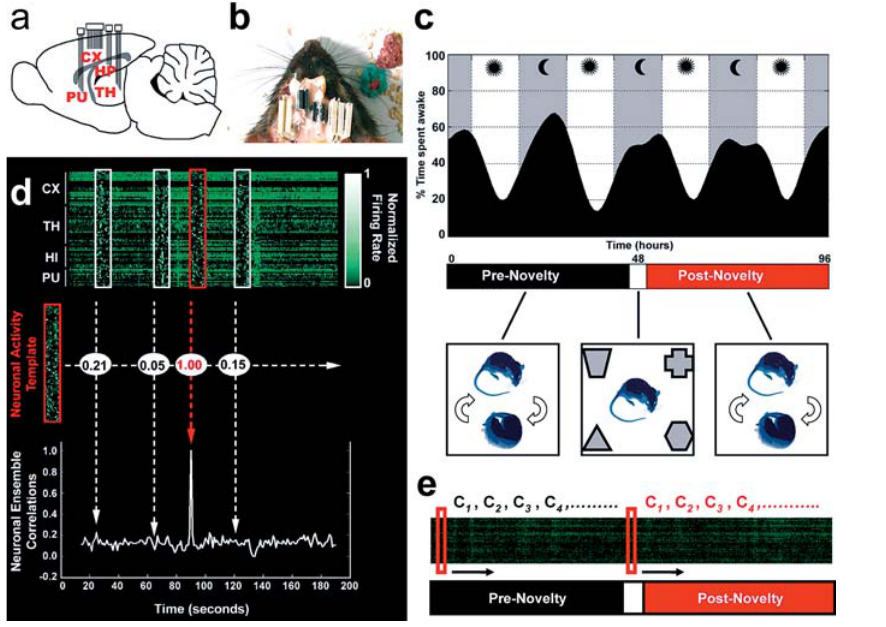
way of an offline template-matching algorithm (Louie and Wilson 2001) that generalizes the notion of pairwise correlations to neuronal ensembles of any size. Templates and targets (white boxes) were binned, firing-rate normalized, and correlated (middle panel). This procedure yields a time series of neuronal ensemble correlations for each template–target sliding match (lower